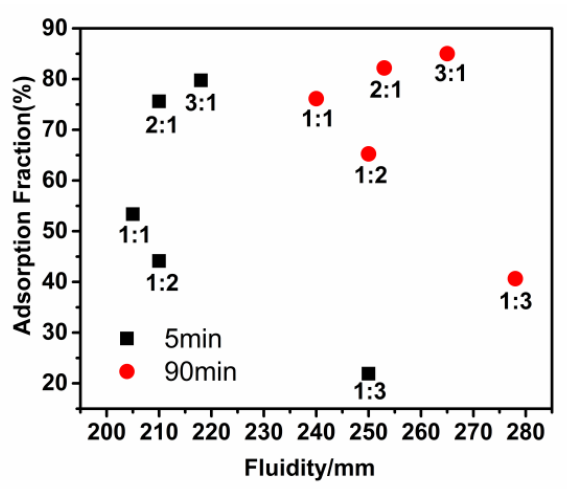
Figure 7. Correlation between adsorption fraction and fluidity.